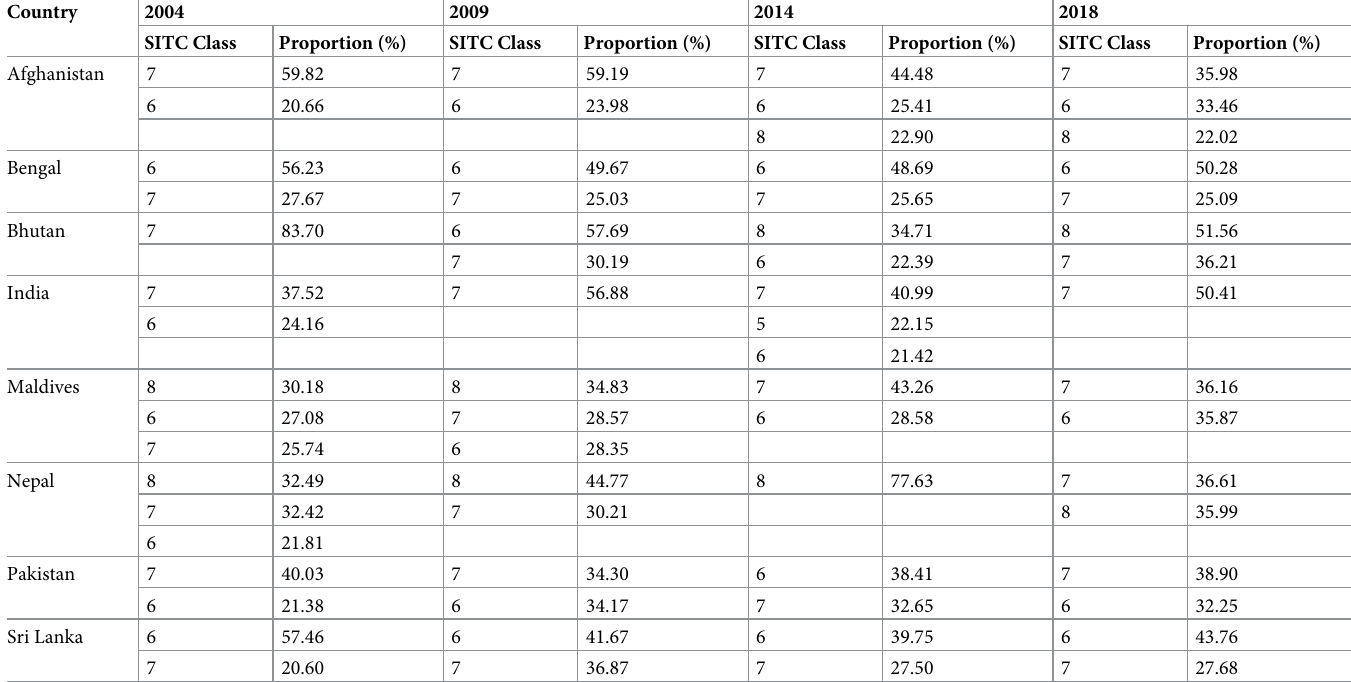
Table 2. The structure of China’s exports to South Asia countries. Country 2004 SITC Class Afghanistan